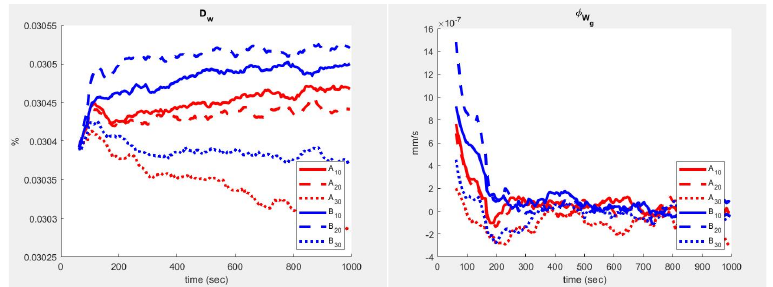
Figure 9. Air absolute humidity response to 1 s human breath in the open chamber.